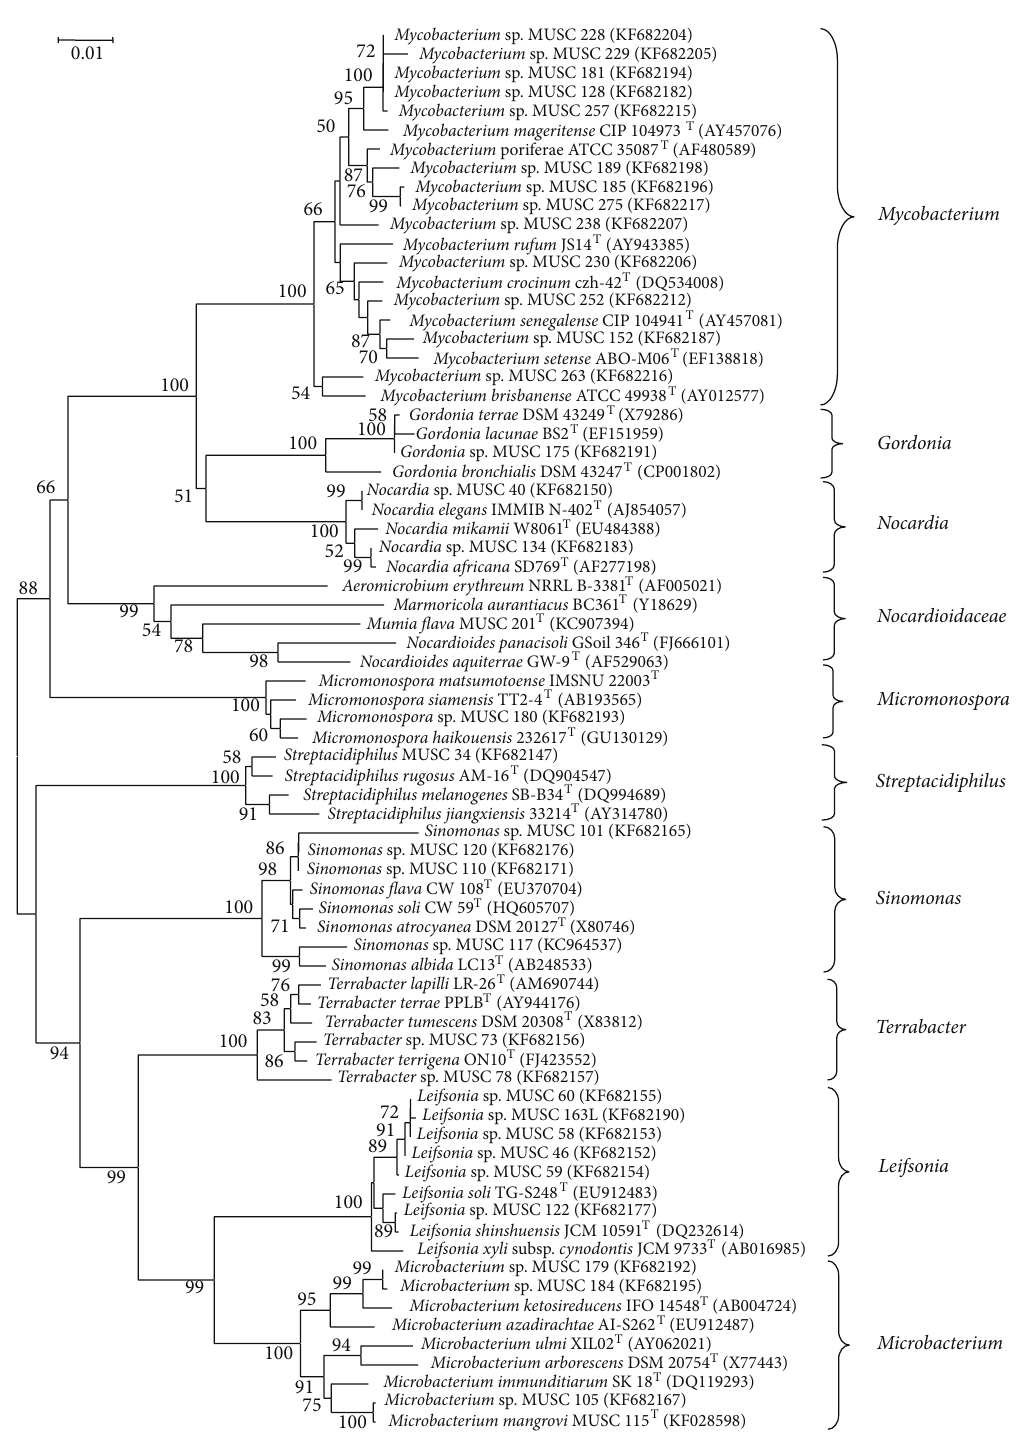
Figure 1: Phylogenetic tree based on 16S rRNA sequences using neighbour-joining method for 35 isolates of non- Streptomyces Actinobacteria and their closely related type strains. Bootstrap values ( > 40%) based on 1000 resampled datasets are shown at branch nodes. Bar, 1 substitution per 100 nucleotide